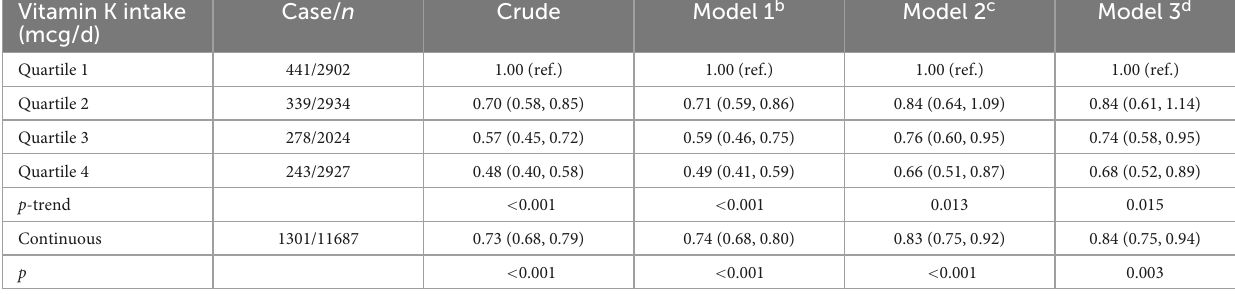
TABLE 2 Odds ratios (95% confidence intervals) for depressive symptoms by vitamin K intake a ( n = 11,687).